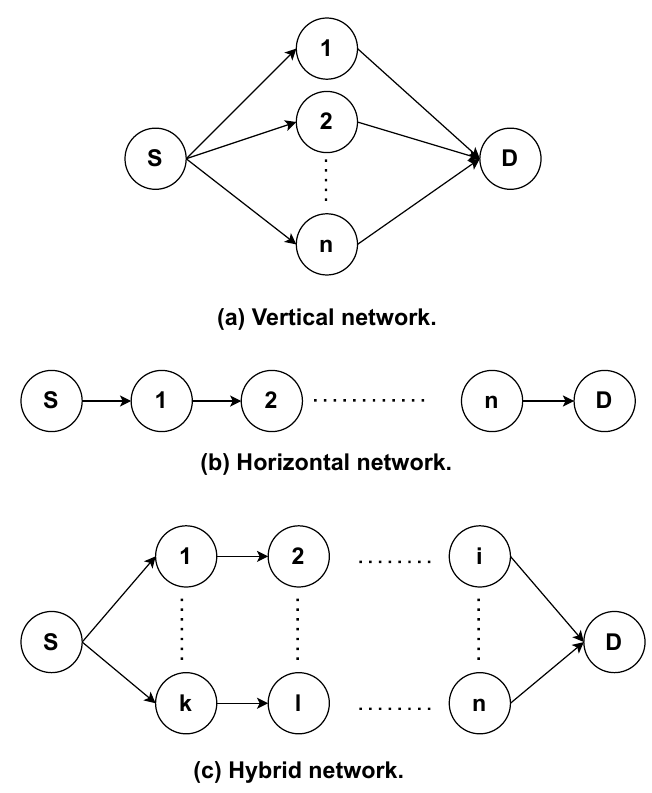
Figure 36. Scenarios of time-complexity